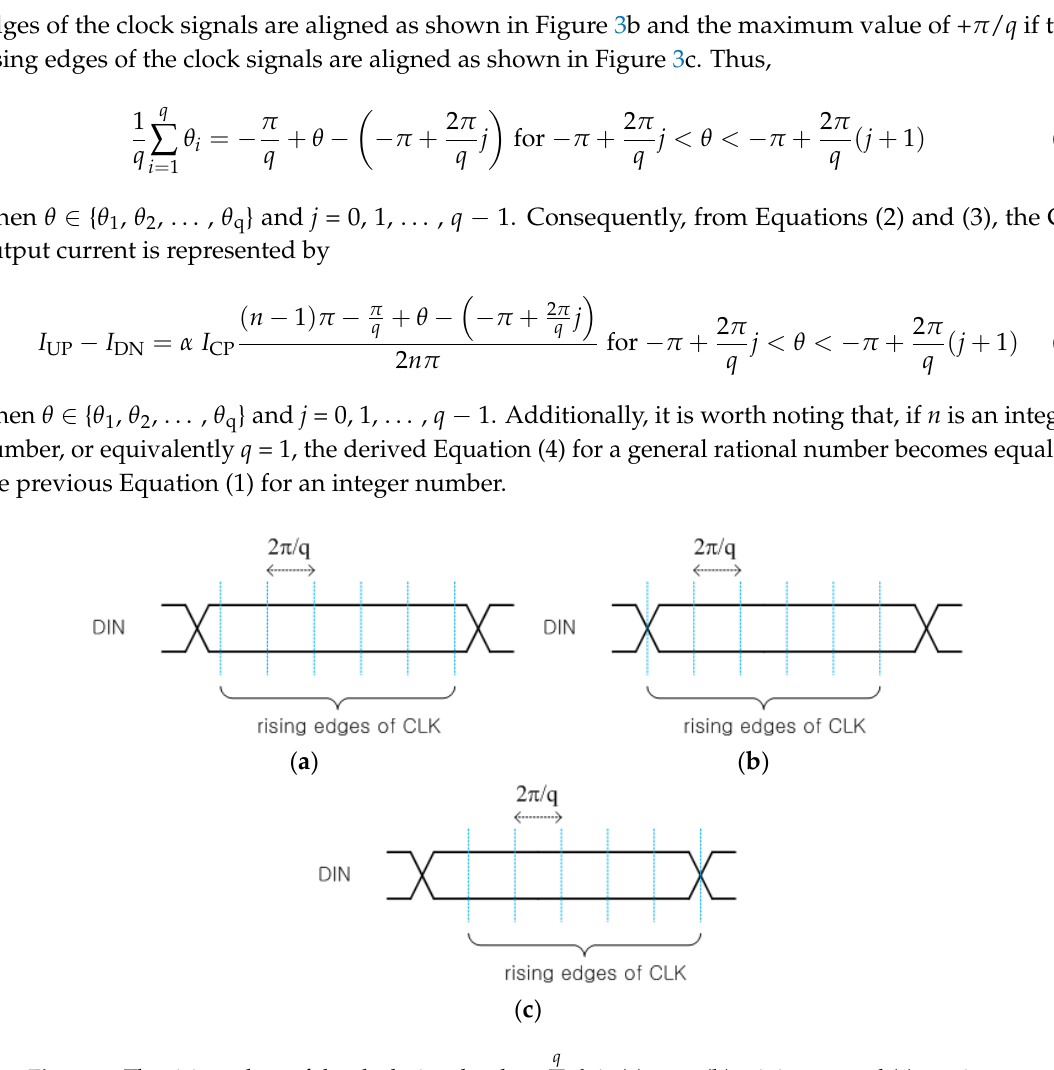
Figure 3. The rising edges of the clock signals when maximum.